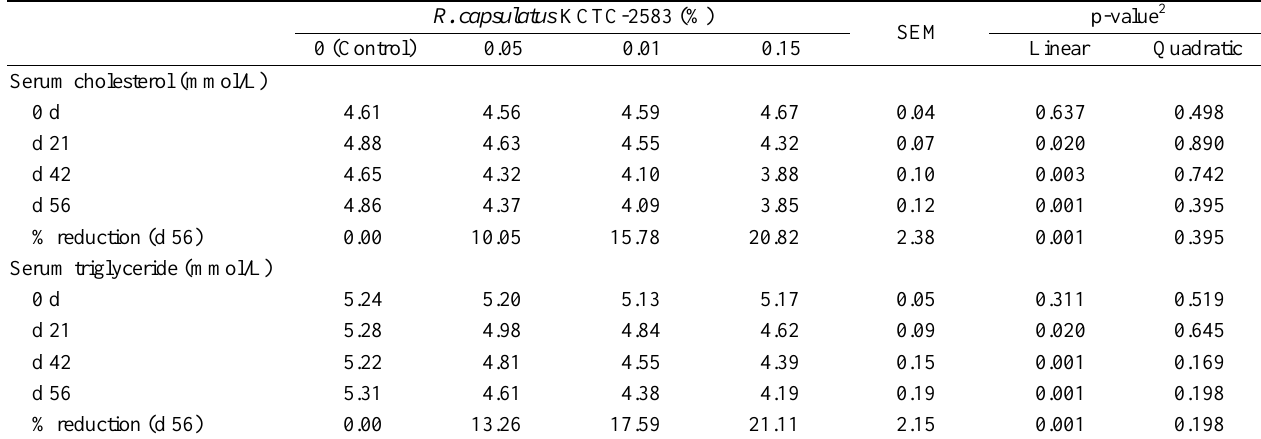
Table 3. Effects of dietary supplementation of Rhodobacter capsulatus KCTC-2583 on serum cholesterol and triglycerides concentrations in laying hen 1